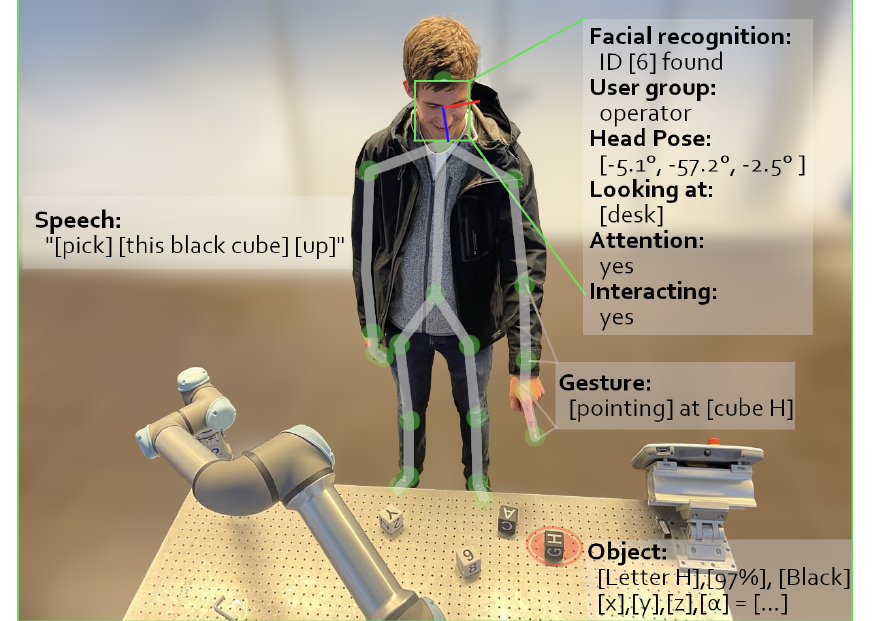
Figure 3. User pointing at a letter Cube. Multiple detected features are displayed for